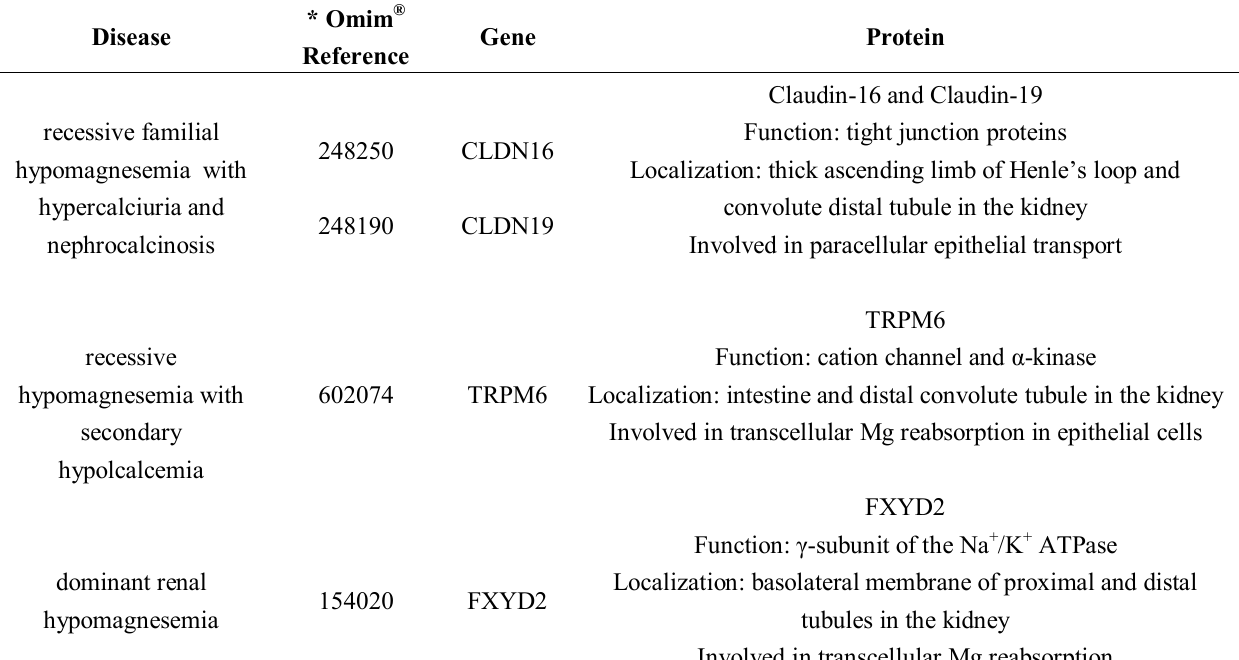
Table 1. Inherited disorders leading to hypomagnesemia. The function of the wild type protein is briefly